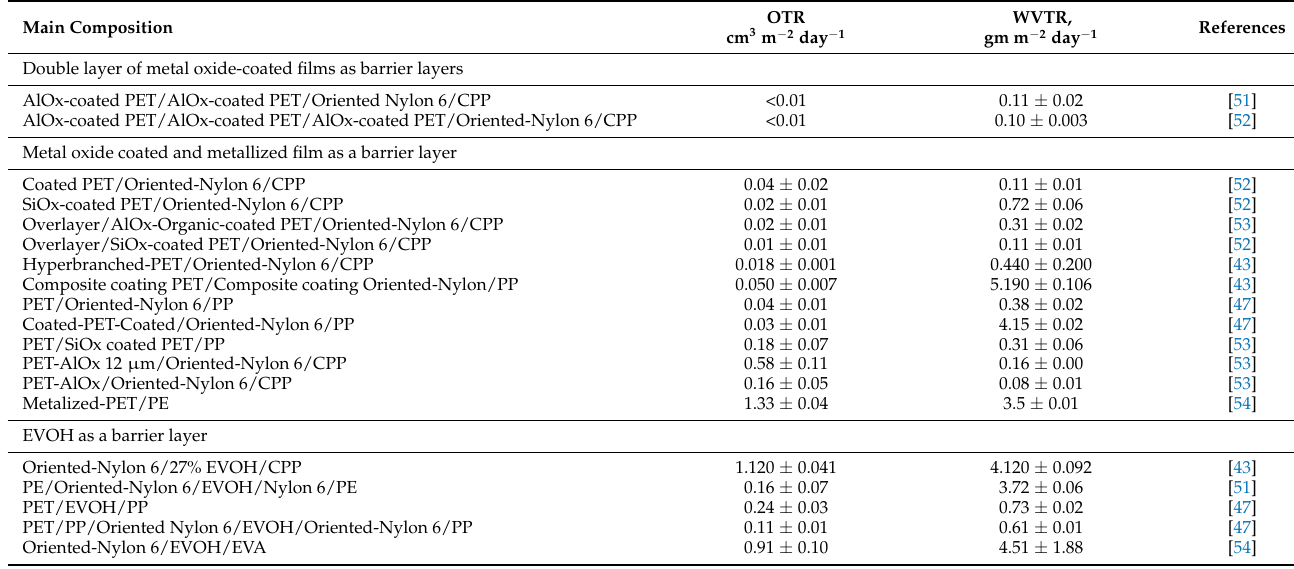
Table 1. Oxygen (OTR) and water vapor transmission rate (WVTR) of some high-barrier multilayer structures.